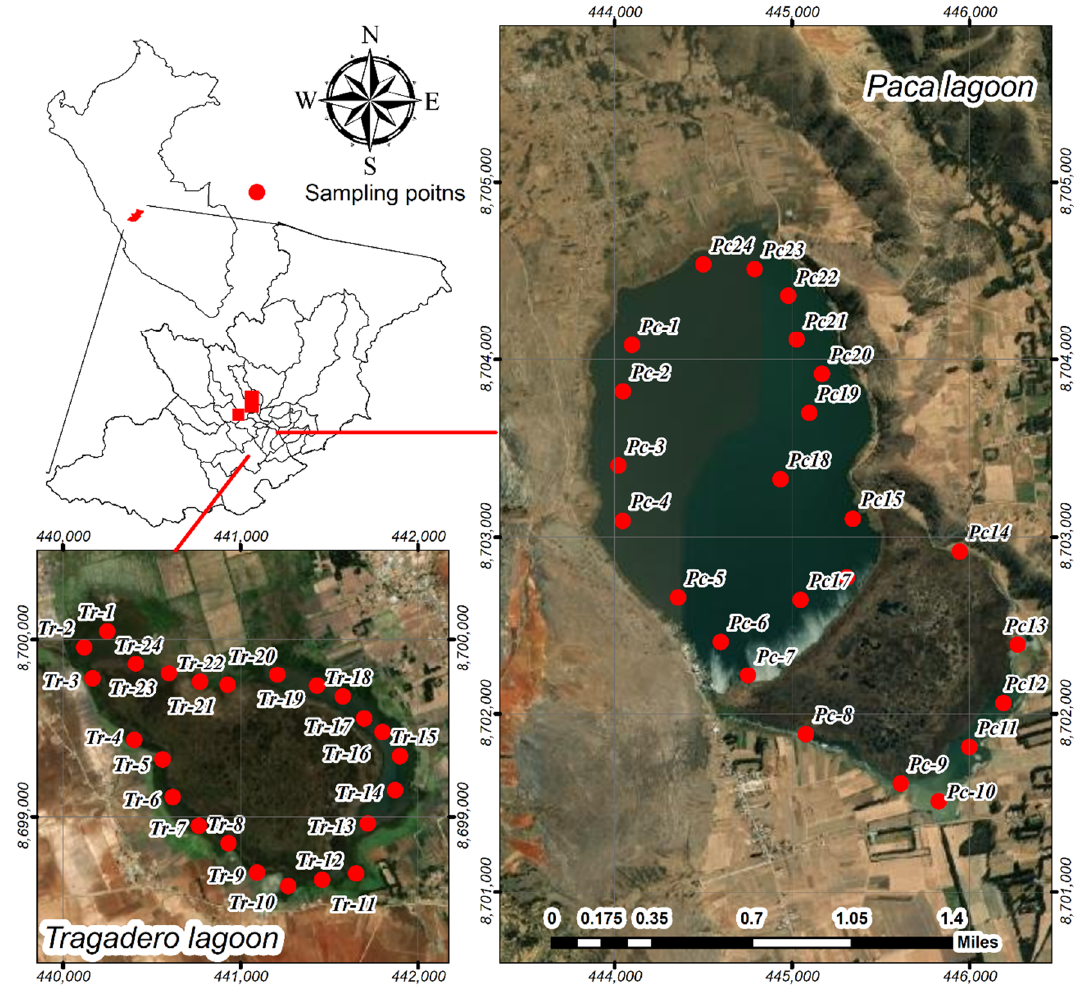
Figure 1. Location of water and sediment sampling sites in the Paca and Tragadero lagoons.